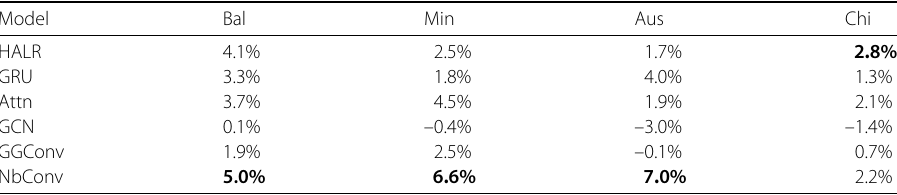
Table 10 Average relative change in F1 score using C + M for violent crimes over all test months (Aug-Dec) in each city Model